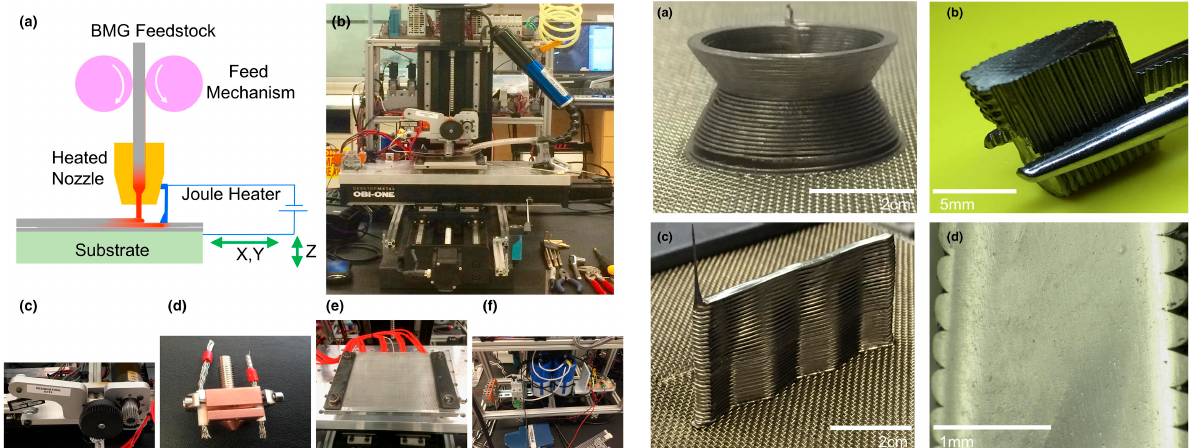
Figure 5. Example of metallic glass printing. The schematic and physical setup of fused filament fabrication (FFF) process for direct-write extrusion of bulk metallic glasses ( a – d, left ): ( a ) schematic, ( b ) physical setup, ( c ) feed mechanism, ( d ) extrusion nozzle, ( e ) heated substrate stage, and ( f ) capacitor bank that generate the applied volatage. The printed bulk metallic glass products ( a – d, right ): ( a ) continuous, ( b ) start-stop printing of BMG, ( c ) printed fully dense and pore-free parts, and ( d ) zoom in view of ( c ). Figures reproduced from [92].